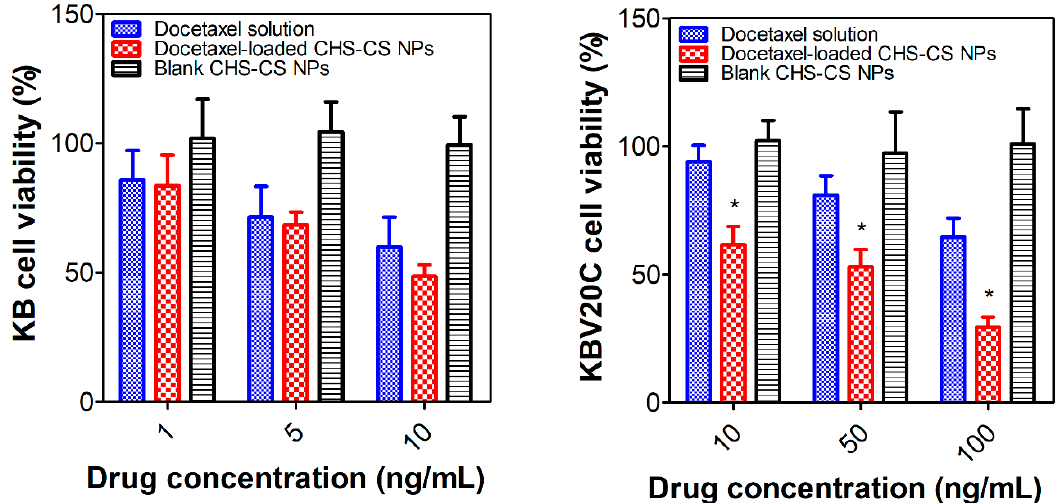
Figure 6. Anti-proliferation assay of designed NPs in KB and KBV20C cells. Docetaxel concentration-dependent cell viability values of docetaxel solution, docetaxel-loaded CHS-CS NPs, and blank CHS-CS NPs in KB and KBV20C cells. Each point represents mean ± S.D. ( n = 3). * p < 0.05.